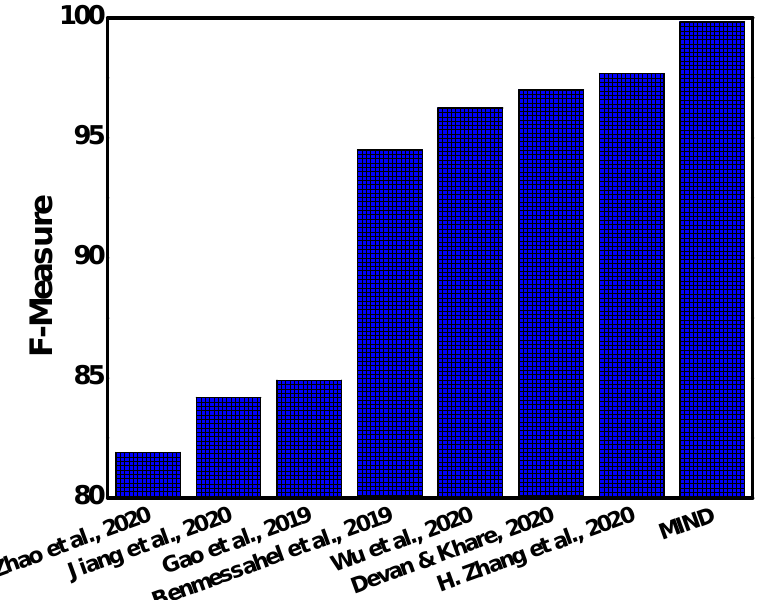
Figure 6. Comparison of F-Measure with existing